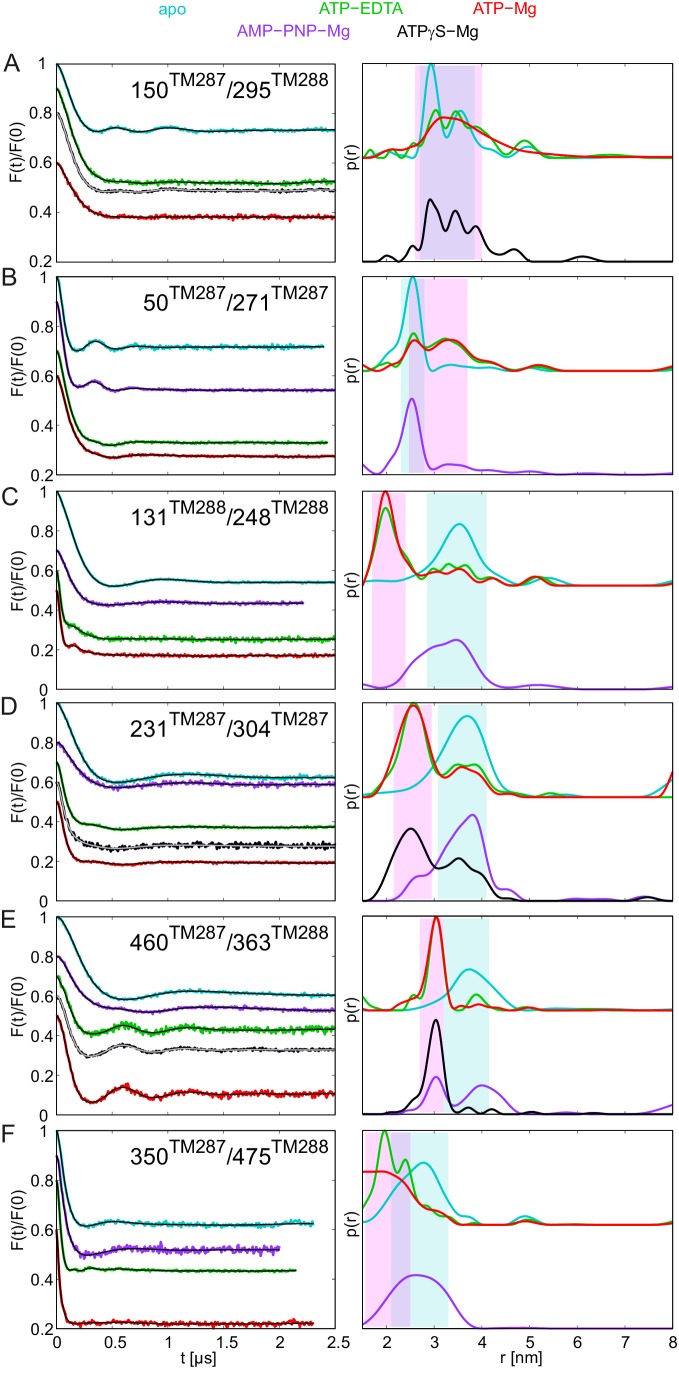
DEER analysis of spin-labeled pairs in TM287/288 carrying the E-to-Q substitution with additional nucleotide analogs.Q-band background-corrected DEER traces [F(t)/F(0)] with fitted distribution function (left) and corresponding distance distribution (right) for the six spin-labeled pairs of TM287/288 carrying the E-to-Q mutation. The upper distance distributions correspond to those presented in Figure 4, the bottom distributions to the additional nucleotide analogs AMP-PNP-Mg and ATPγS-Mg. Color code as described in the figure legend. (A and B) Extracellular pairs 150TM287/295TM288 and 50TM287/271TM287. (C and D) Intracellular pairs 131TM288/248TM288 and 231TM287/304TM287. (E) NBD pair 460TM287/363TM288 monitoring the consensus site. (F) NBD pair 350TM287/475TM288 monitoring the degenerate site.